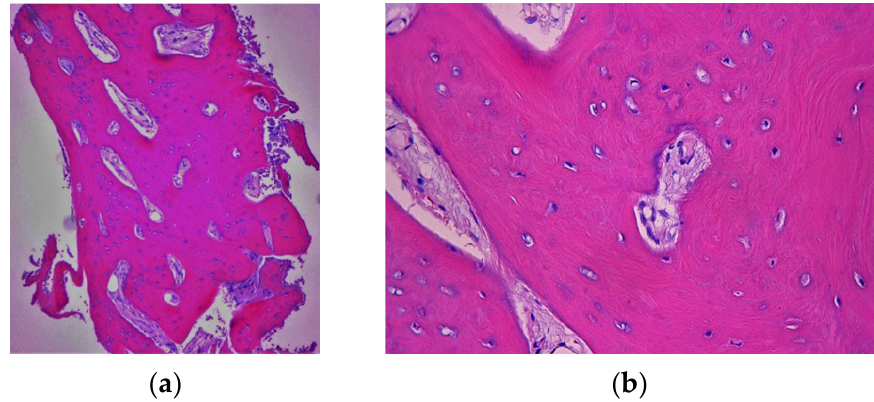
Figure 5. ( a , b ) histological examination which confirms the presence of only newly formed bone tissue.